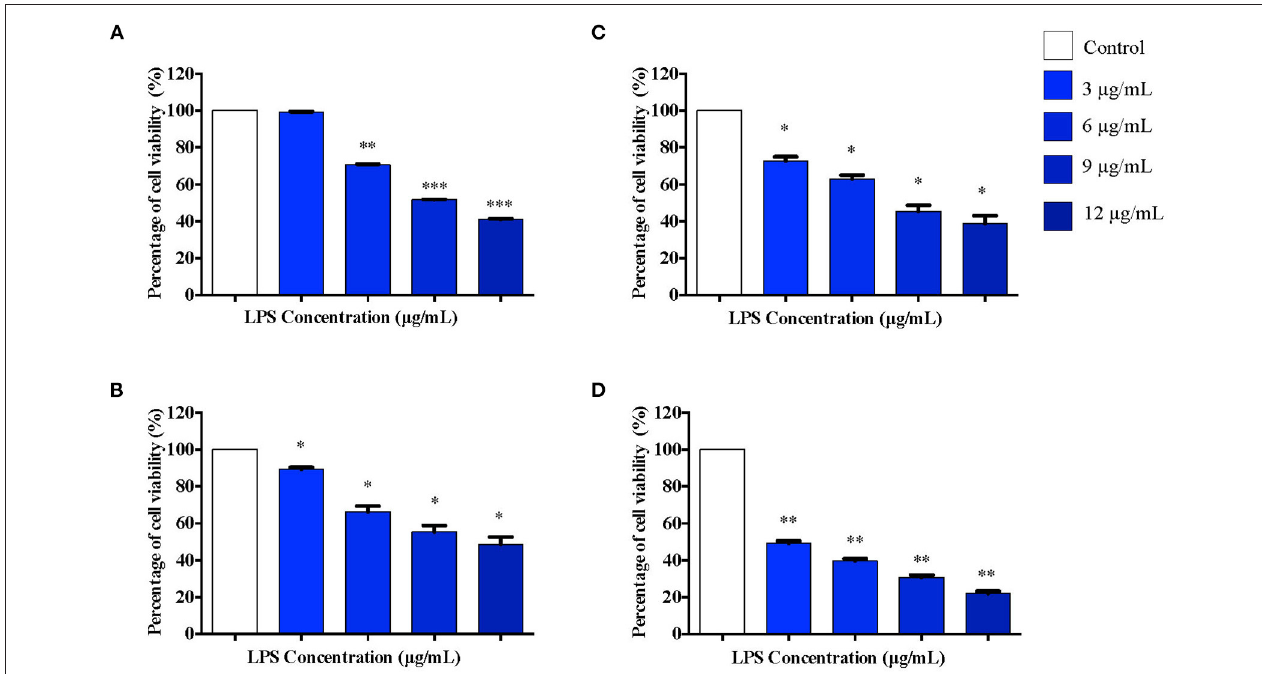
FIGURE 3 | The differentiated PC12 cells were exposed to 3, 6, 9, and 12 µ g/mL LPS for (A) . 12, (B) . 24, (C) . 48, and (D) . 72h. Cell viability was determined by MTT assay. Bars represent mean data ± S.E.M from three independent experiments. Data were analyzed using one-way ANOVA, followed by a Bonferroni post-hoc test. Percentage of cell viability of LPS-stimulated cells was compared to control. * p < 0.05, ** p < 0.01, *** p < 0.001 considered to be statistically